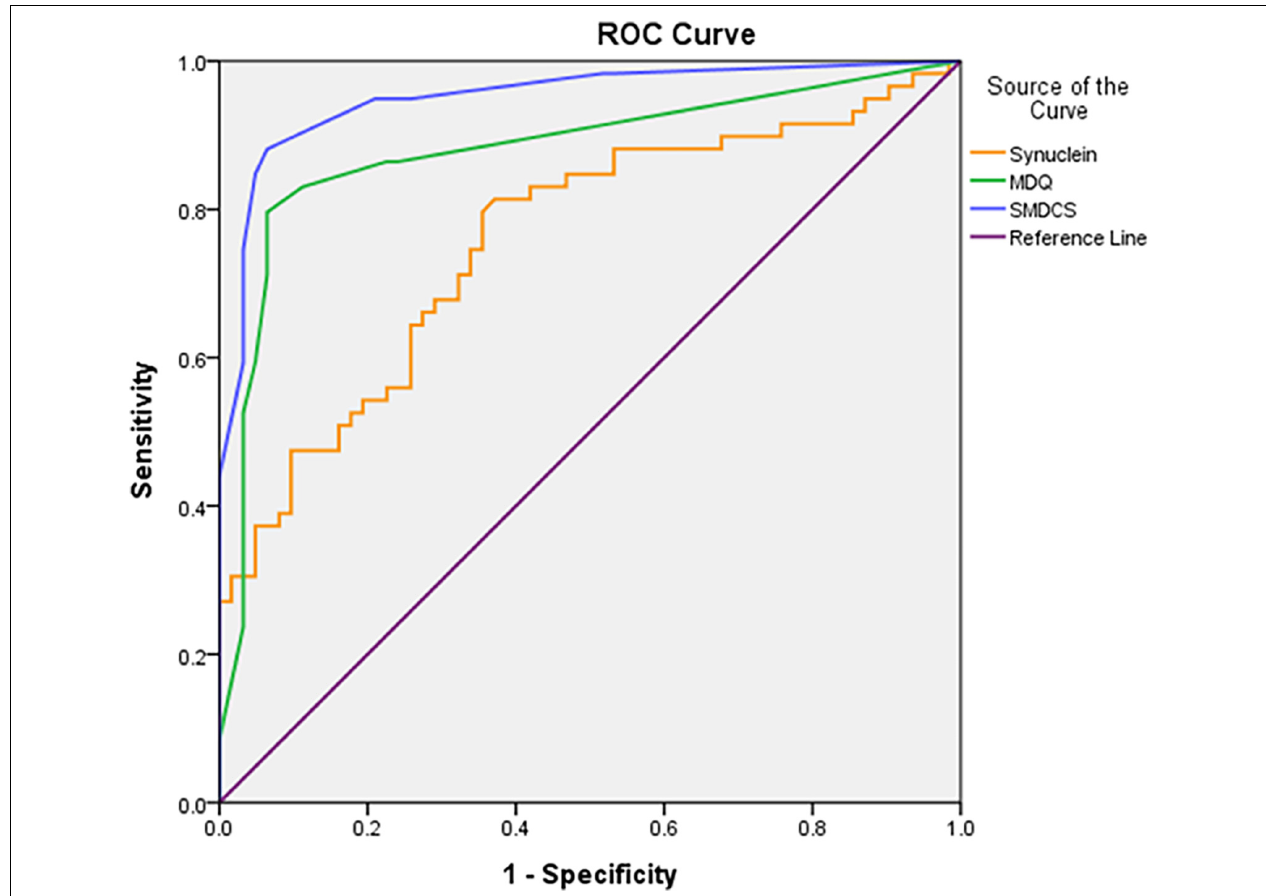
FIGURE 1 | The ROC curves analysis of plasma α -synuclein, MDQ, and SMDCS between DLB versus non-DLB.